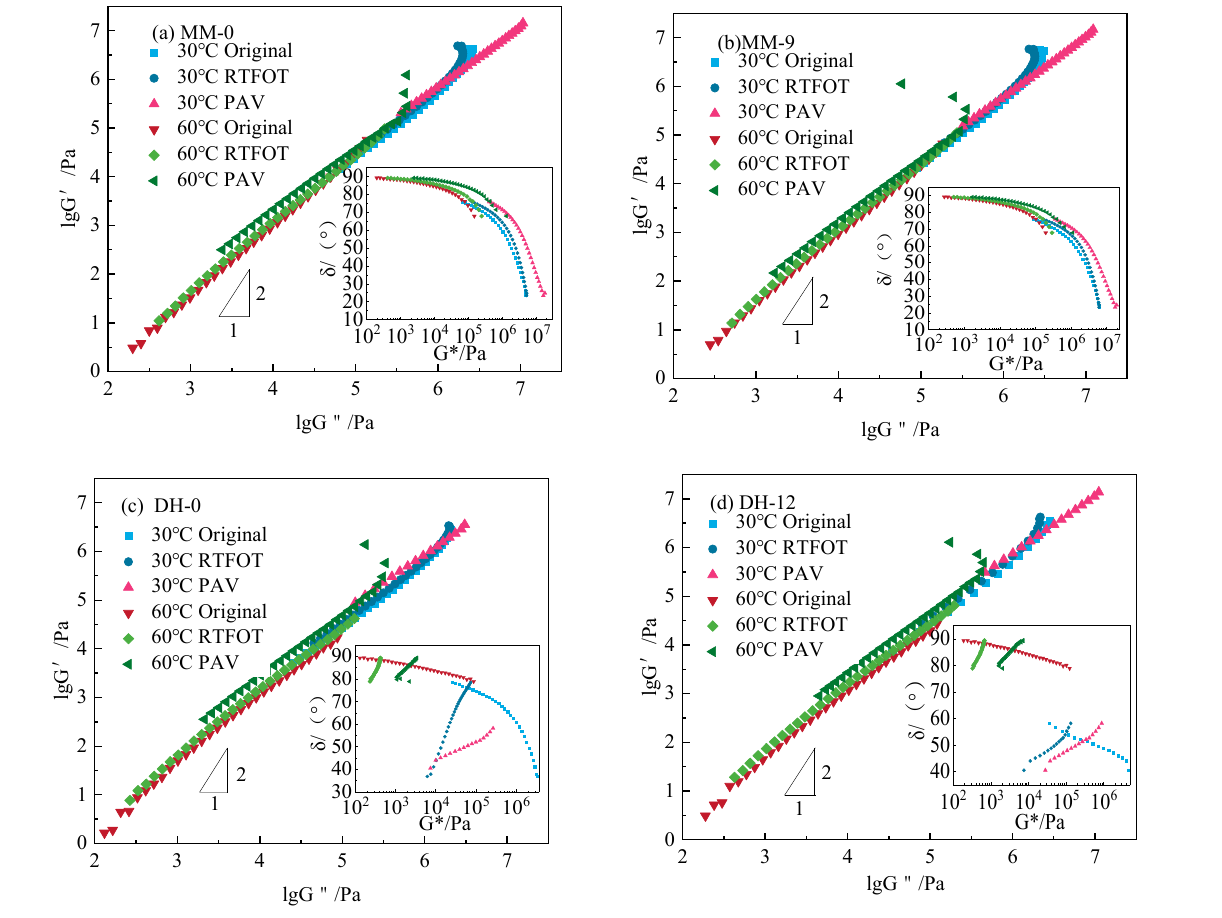
Figure 11. Han diagram and VGP diagram of two asphalts and lignin-modified asphalt under different aging conditions. ( a – d ) represent two types of asphalt with different temperatures and different aging. It can be seen in Figure 11 that the Han curves of the two asphalts and the lignin- modified asphalt with different lignin contents were approximately straight lines at high temperatures before aging, and the slope of the Han curve was close to 2, which indicated that the asphalt binder belonged to a homogeneous mixed system at this temperature. The lignin had good compatibility with the matrix asphalt. However, the bifurcation phenomenon occurred in the unaged state at low temperatures, indicating that there was microscopic phase separation at low temperatures. After RTFOT aging, the two original asphalts and the lignin-modified asphalt with different lignin contents appeared to show bifurcation at a low temperature, but did not separate at a high temperature, indicating that the compatibility of original asphalt and lignin-modified asphalt was better in high- temperature conditions. After PAV aging, the base asphalt and modified asphalt both displayed the separation phenomenon at high temperatures, but there was no separation at low temperatures, which indicated that thermal oxygen and pressure aging promoted the decomposition of matrix asphalt and modified asphalt, resulting in large differences in inter- nal molecular weight distribution. In the VGP curve, it was found that the aged Maoming 70# base asphalt and lignin-modified asphalt were superimposed at different temperatures, while the Donghai 90# base binder and lignin-modified asphalt were superimposed only before aging. The dispersion of different aging states could not be superimposed, indicating that the 70# binder was more compatible than the 90#